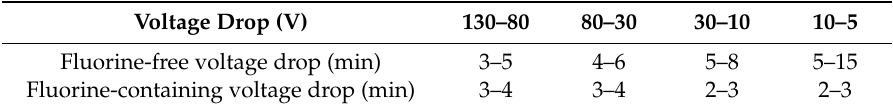
Table 1. Comparison of the time of the traditional voltage drop method and the traditional voltage drop method in combination with fluoride ions.